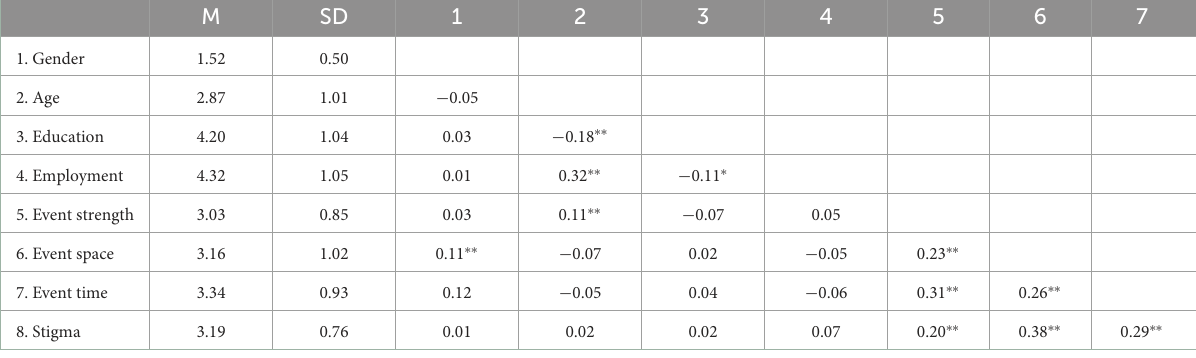
TABLE 1 The descriptive statistics and correlation coefficients.